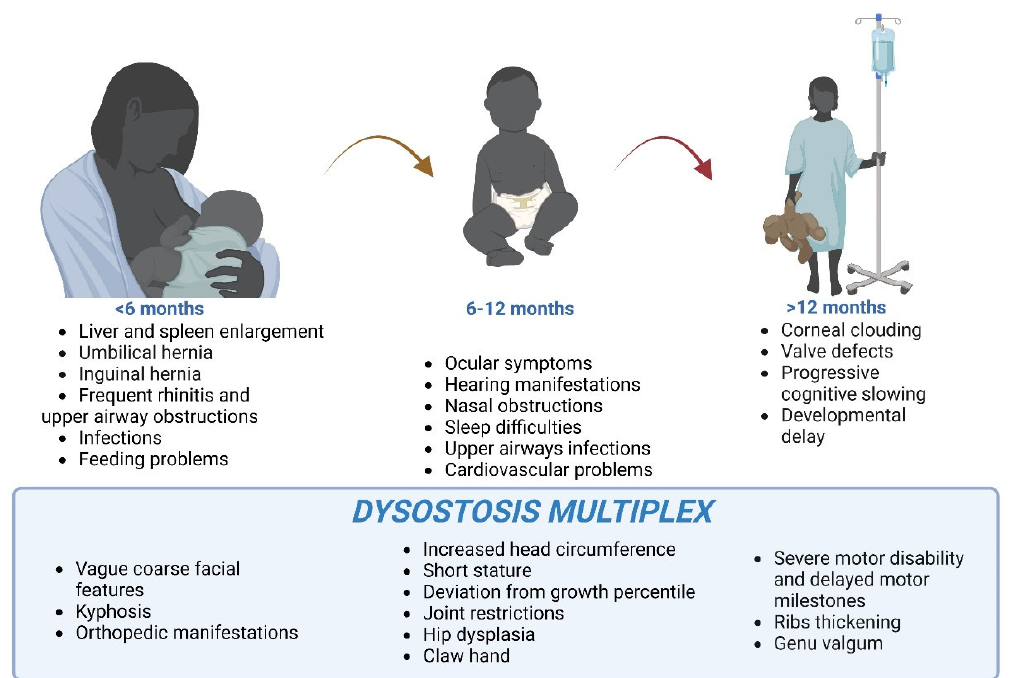
Figure 1. Disease manifestation onset in severe MPSI patients. Timeline of clinical manifestations in severe MPSI with focus on skeletal findings. Created with BioRender.com (accessed on 20 September 2022).